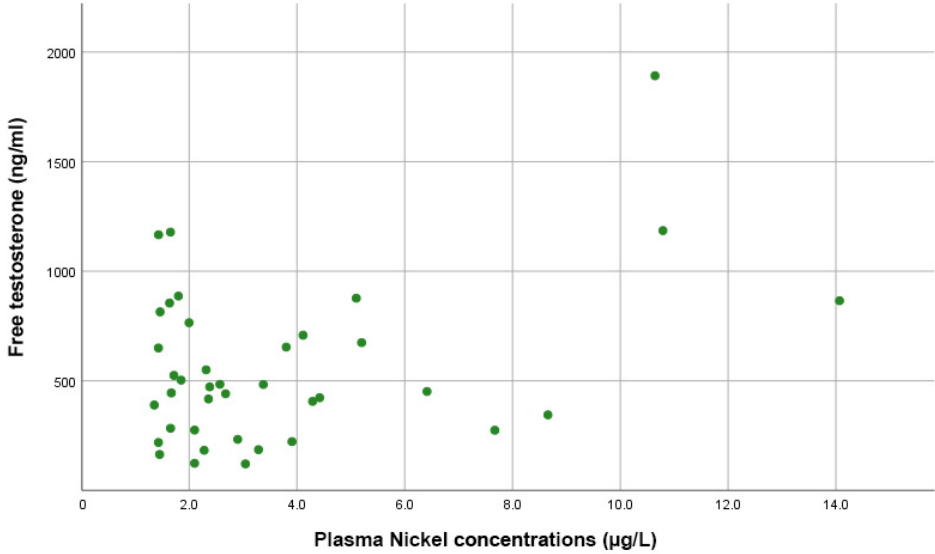
Figure 4. Scatter plot showing the direct proportional correlation between free testosterone levels and plasma nickel levels in PCa patients.